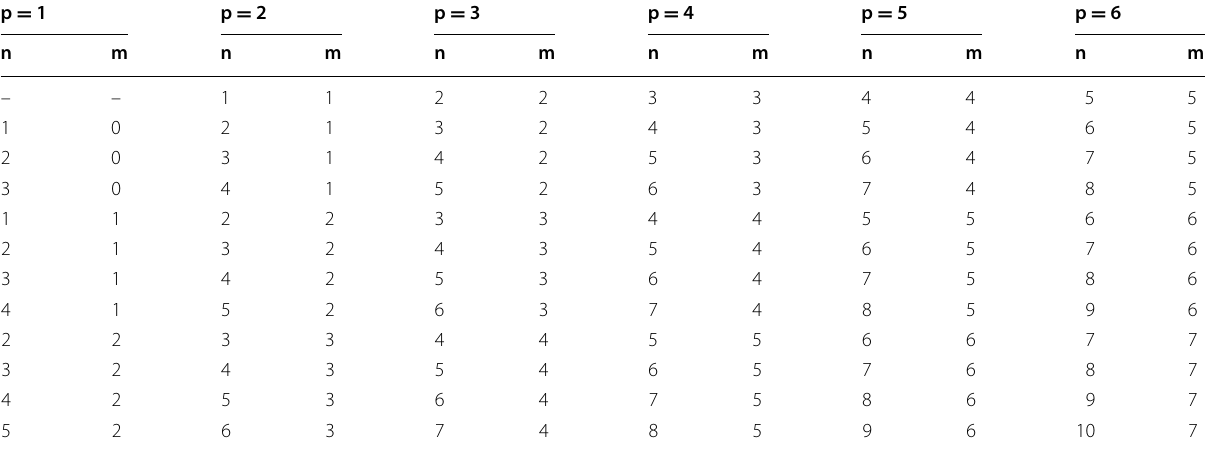
p , n , and m denote the time harmonic, degree, and order, respectively. For more details, see the text